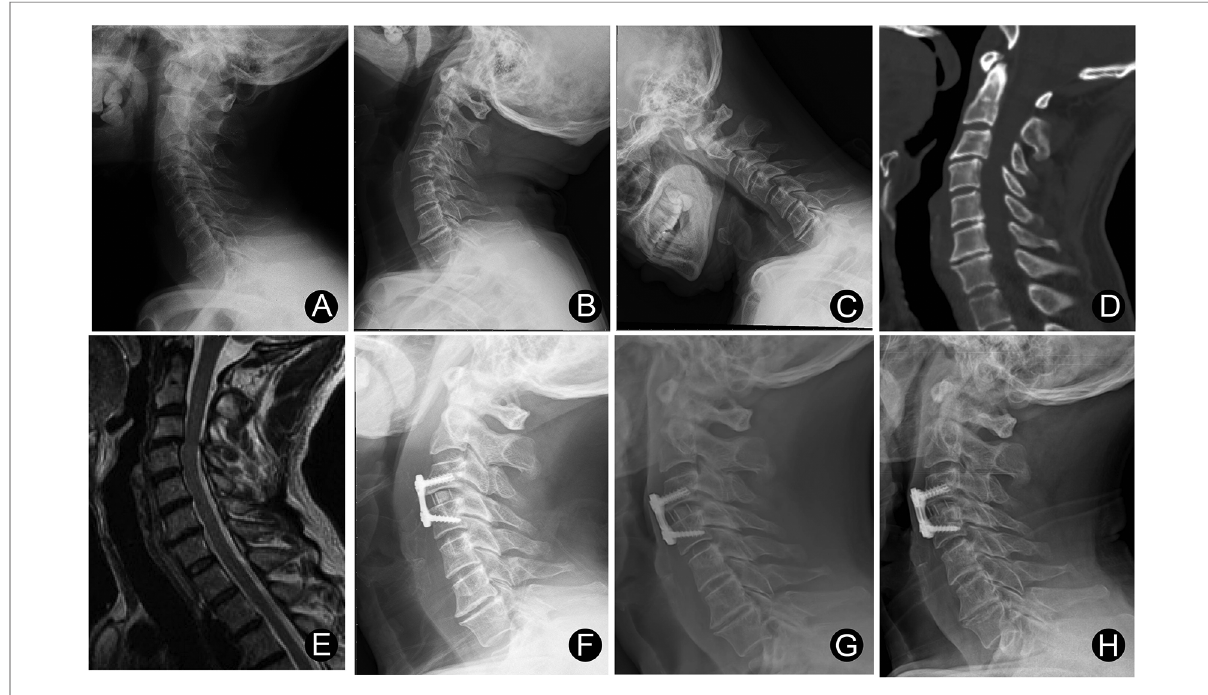
FIGURE 1 Male, 57 years old: C3/4 ACDF was experienced. ( A – C ) Cervical spine x-ray showing C3/4 instability. ( D ) Preoperative cervical CT sagittal image. ( E ) Magnetic resonance imaging (MRI) showing no signi fi cant compression of the spinal cord. ( F ) x-ray of cervical spine 3 months after surgery. ( G ) x-ray of cervical spine 12 months after surgery. ( H ) x-ray of cervical spine 24 months after